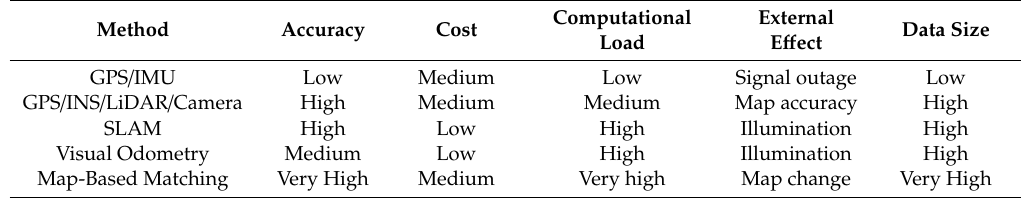
Table 5. Comparison of localization and mapping techniques in terms of the accuracy, cost, computational load, source of external e ff ects, and the storage size of